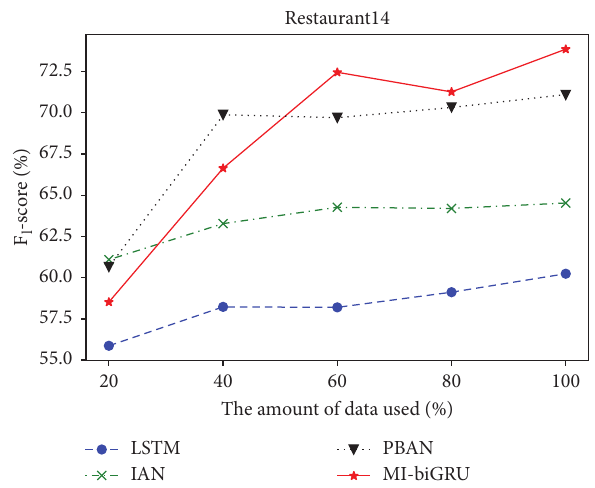
Figure 4: F1-score trend of baseline models in restaurant domain.